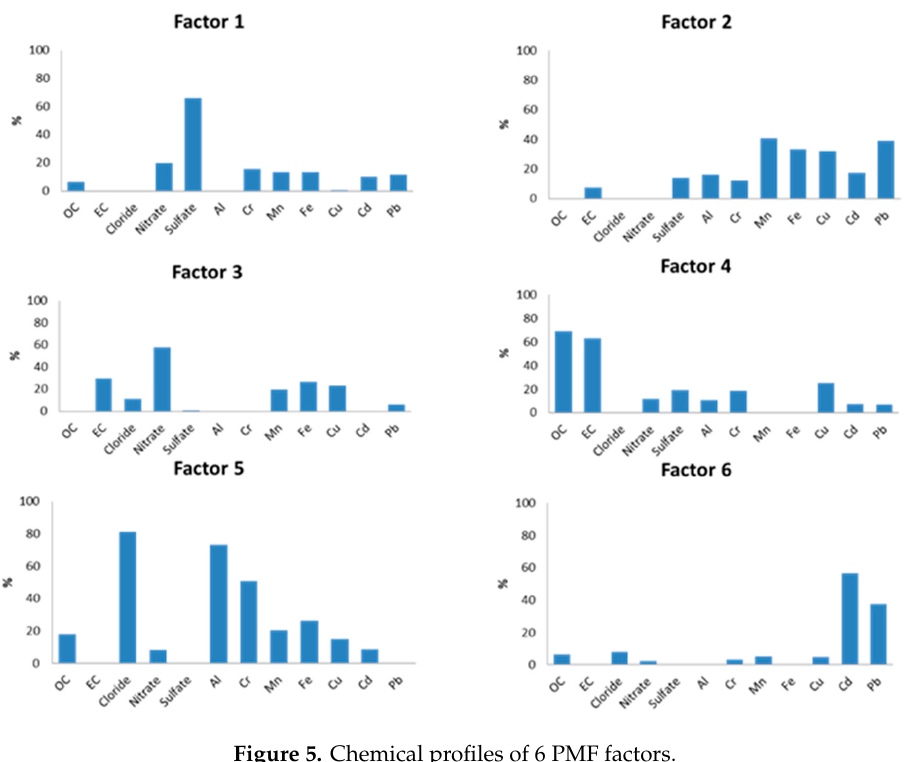
Figure 5. Chemical profiles of 6 PMF factors.